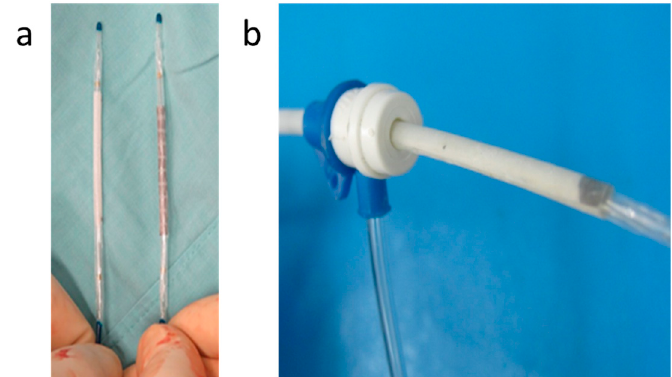
Figure 10. In situ welded endovascular device preparation: ( a ) Sterilized sleeve (left) and coated stent (right) mounted on expandable balloons; ( b ) The device was easily inserted through an 8F vascular introducer sheath.